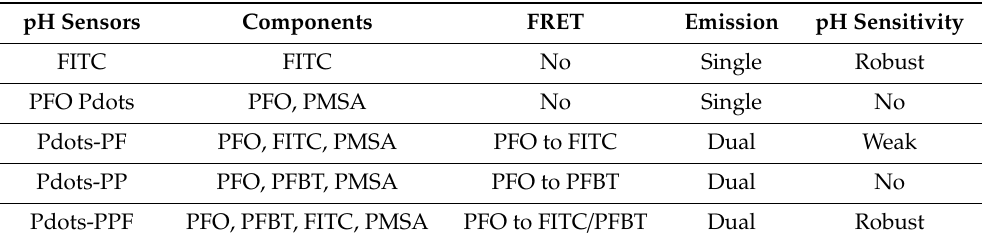
Table 2. Comparison of pH sensors used in this study.